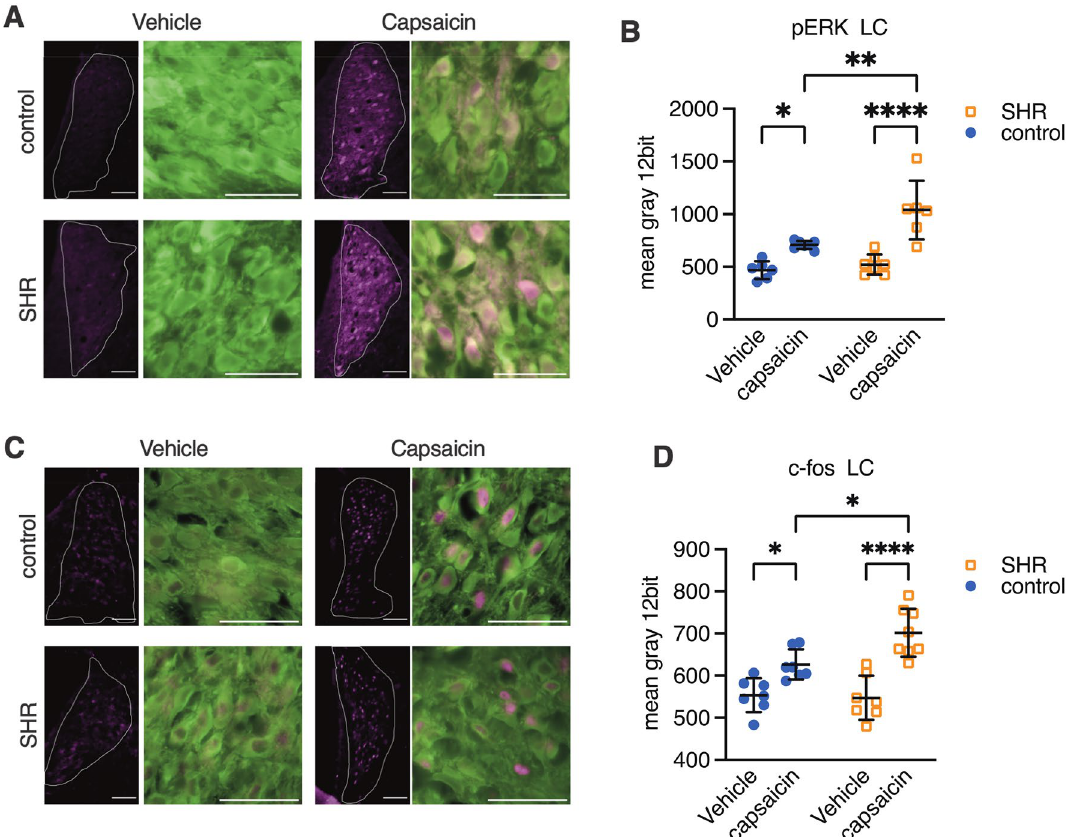
Figure 3. Capsaicin-evoked activation of locus coeruleus noradrenergic neurons. Representative pictures of pERK-immunoreactivity (IR) in the locus coeruleus (LC) area are shown in ( A ). 30 min after capsaicin or vehicle injection to the left forepaw, the brain tissue was collected and stained. Low-magnification images are shown on the left. The white dot lines show the LC area determined by dopamine beta hydroxylase (DbH) -IR. pERK-IR pixels are shown in magenta. In the right pictures, DbH-IR is presented in green and pERK-IR is presented in magenta. The mean gray value of pERK-IR from each noradrenergic neuron was measured, and the average value was calculated for each rat ( B ). There are no statistical differences in pERK between the strains after vehicle injection. Capsaicin injected animals show higher IR of pERK than vehicle injected animals. Representative pictures of c-fos-IR in the LC area 60 min after capsaicin or vehicle injection are shown in ( C ). There are no statistical differences in c-fos between the strains after vehicle injection. Capsaicin injected animals show higher IR of c-fos than vehicle injected animals. Mean ± SD, *; p < 0.005, **; p < 0.01, ****; p < 0.0001. n = 8 each. Dot line: LC is determined by DbH-IR, Scale bar = 200 µm (left), 100 µm (right). SHR: spontaneously hypertensive rats (a model of attention deficit hyperactive disorder: ADHD), control; Wister